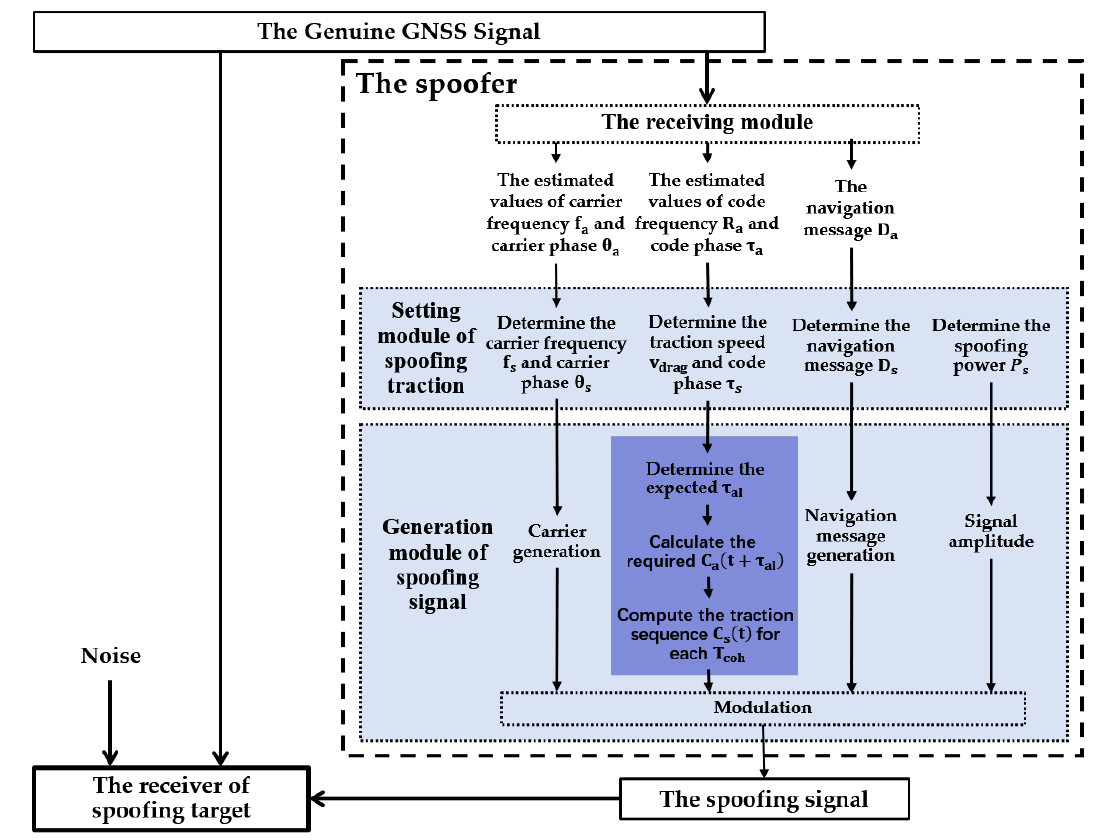
Figure 10. Schematic diagram of the spoofer applying the proposed traction strategy. Strategy